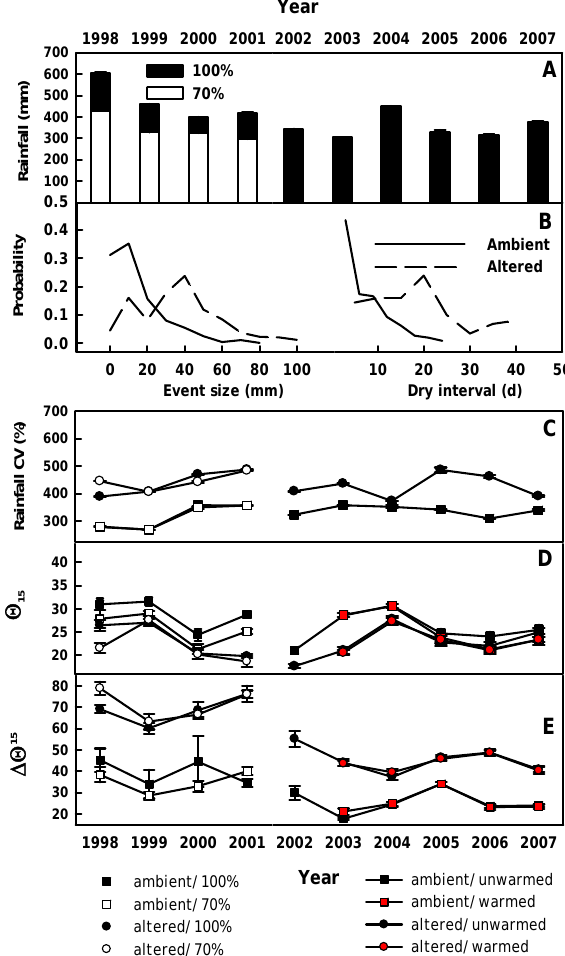
Fig. 1. Annual rainfall inputs and soil moisture means and variabil- ity in the RaMPs experiment during the rainfall pattern x quantity treatments (Phase I, 1998–2001) and the rainfall pattern x warming treatments (Phase II, 2003–2007). (A) Total growing season rain- fall. (B) Probability density functions of individual rainfall event size (100% treatments) and dry interval length. (C) Coefficient of variation (CV) of daily rainfall inputs during the growing season. (D) Mean volumetric soil water content for 0–15cm ( 2 15 ). (E) Mean change in 2 15 between successive rainfall events ( 12 15 ). Error bars denote one SE.